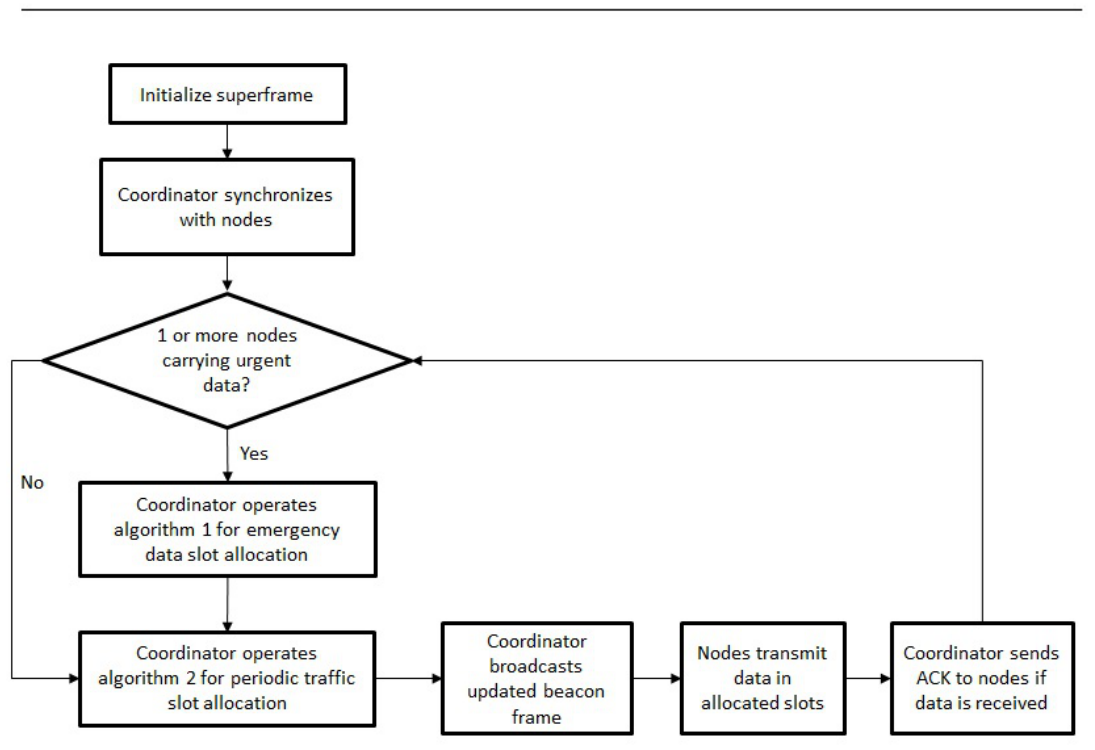
Figure 3. Block Diagram of Protocol Data Transfer